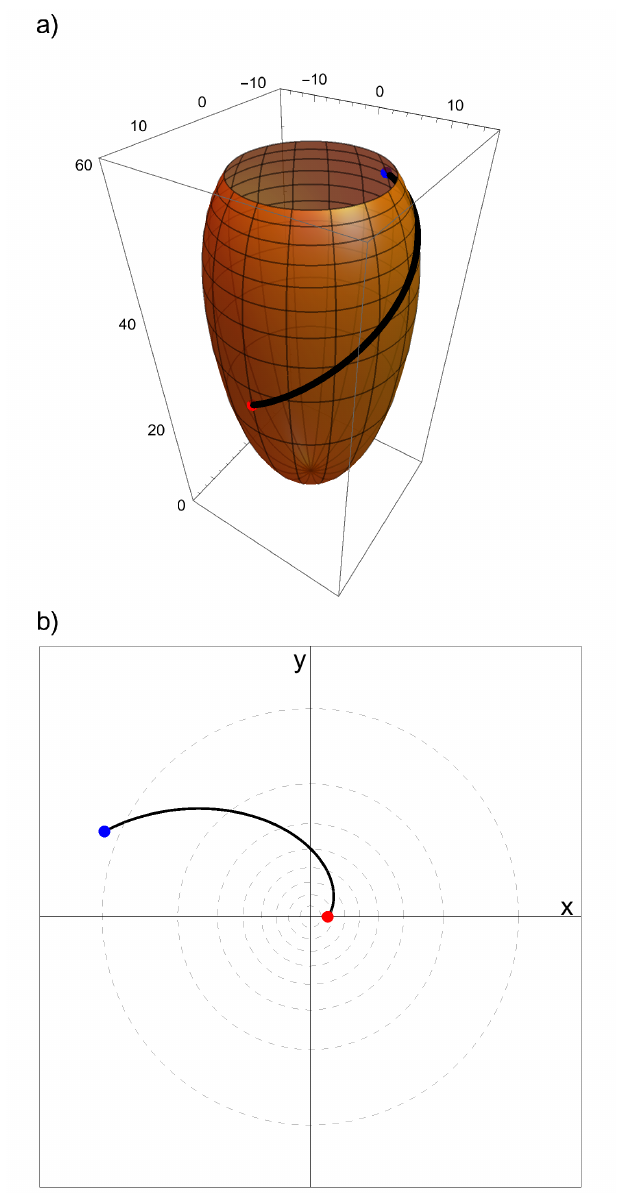
Figure 3. ( a ) example of a geodesic orbit on V 1 connecting a red point at coordinates ( w 0 = 0.25, φ 0 = 0) with a blue point at coordinates ( w f = 13 π r t = 11.1808 or ψ 0 = 53.68 degrees for this geodesic orbit; ( b ) diffeomorphic image of the same geodesic orbit on V 1 stereographically projected from the S 2 visual field to its tangent polar plane E 2 at z = 0. A = 525.6 and B =